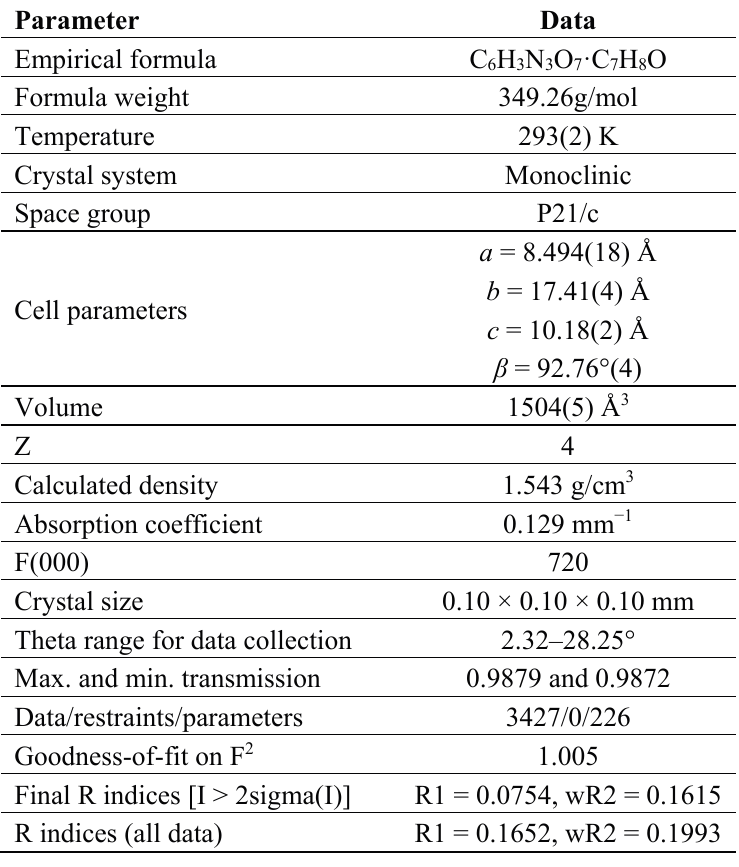
Table 1. The crystal data of picric acid/acetophenone